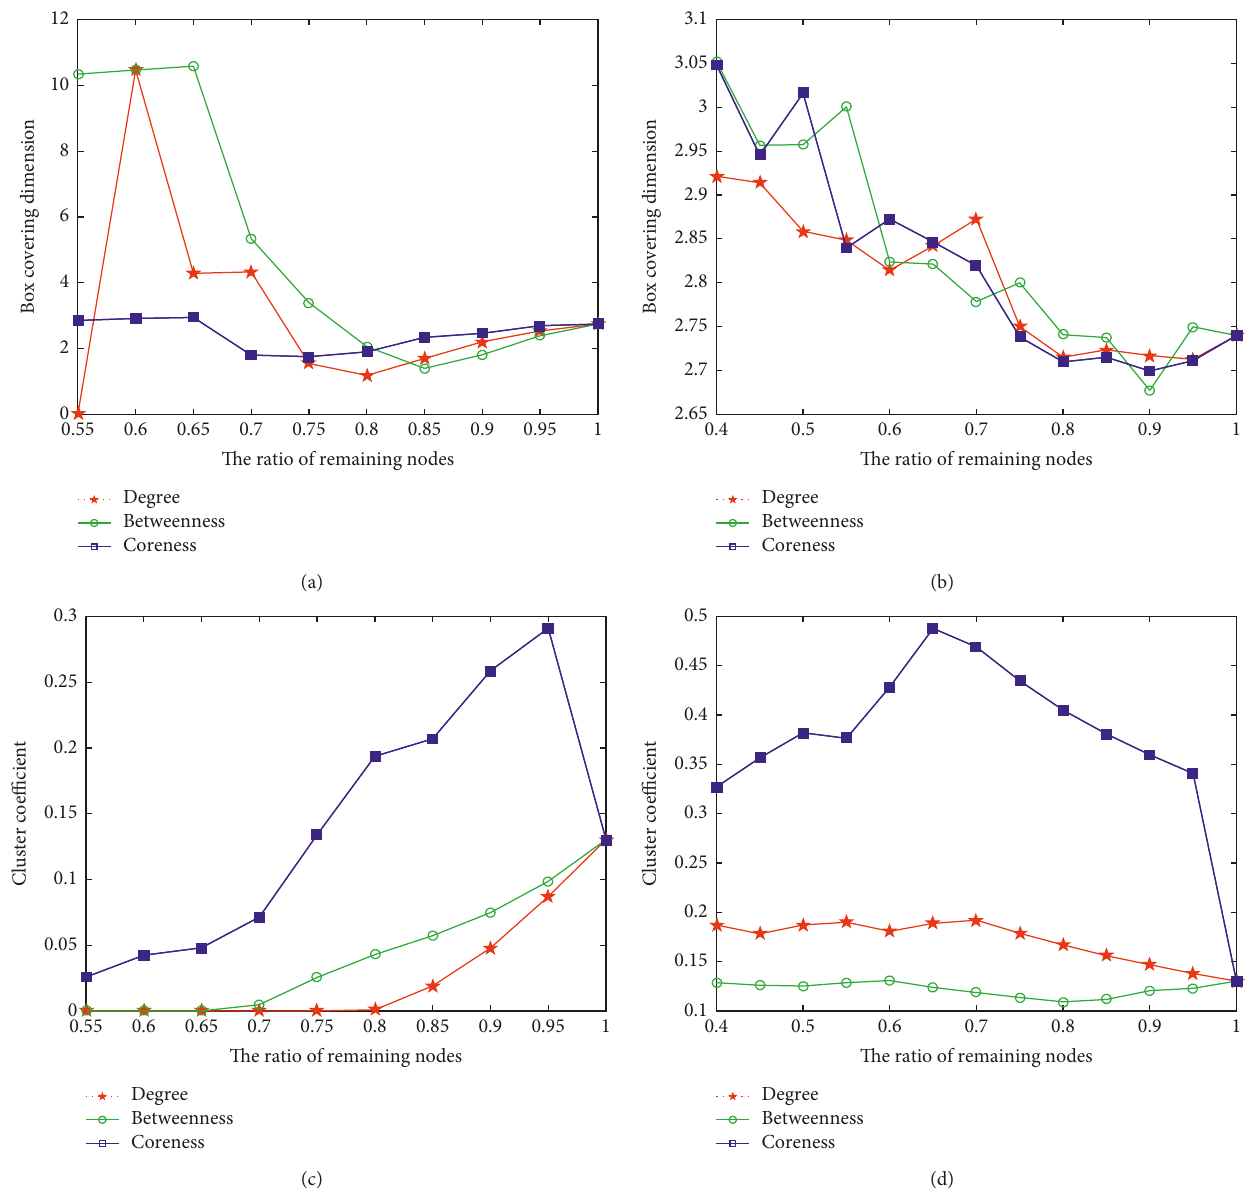
Figure 5: Changes of box dimension and cluster coefficient of YPI network, after nodes are removed by sorting. The X -axis represents the number of nodes remaining in the network. (a) Nodes are removed by degree, betweenness, and coreness in the descending order. The first 5% of the biggest nodes are removed from the network in each rank, and the dimension of remaining network is calculated. (b) Nodes are removed by coreness in the ascending order. The first 5% of the smallest nodes are removed from the network, and the dimension of remaining network is calculated. (c) The changes of cluster coefficient after nodes are removed by degree, betweenness, and coreness in the descending order. (d) The changes of cluster coefficient after nodes are removed by degree, betweenness, and coreness in the ascending